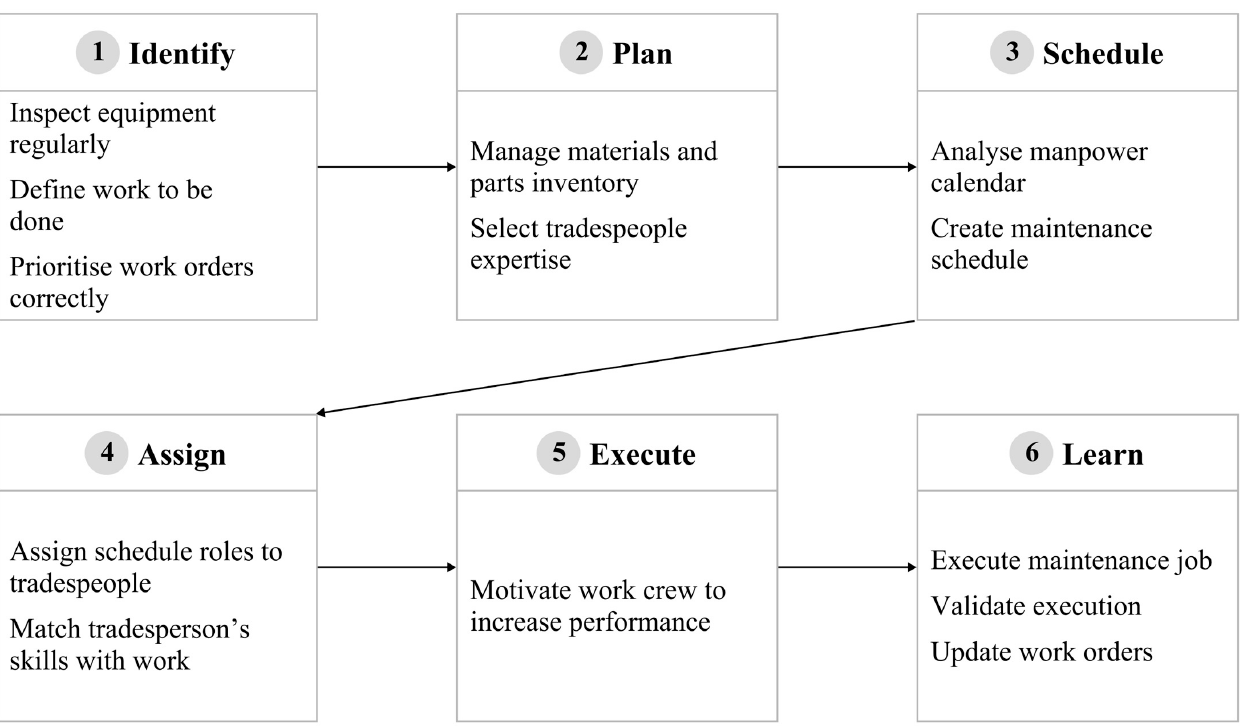
Figure 1. Six key steps in effective maintenance management according to [10].